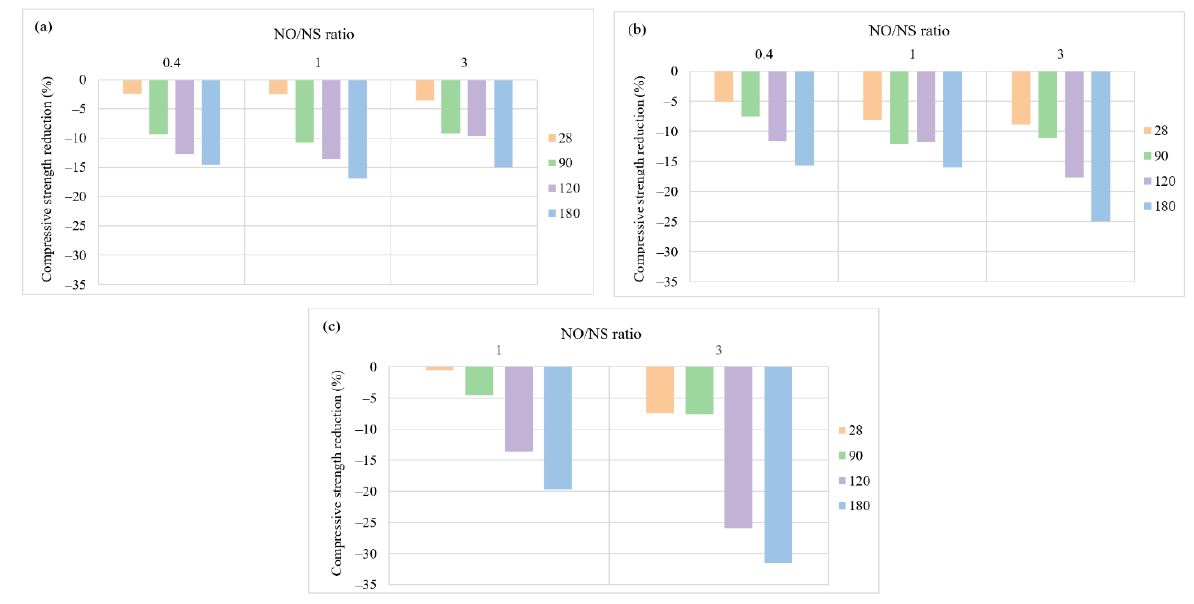
Figure 8. The effects of NO/NS ratios on compressive strength reduction at a molarity of ( a ) 6, ( b ) 10, and ( c ) 14.